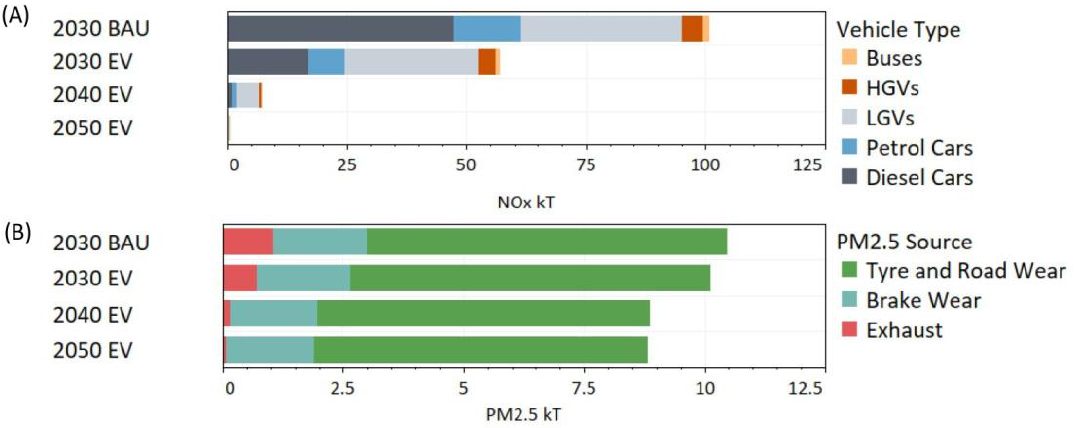
Figure 6. Projected emissions from road transport to 2050 for EV scenario; ( A ) NOx emissions, where colour shows the emissions from each vehicle type; and ( B ) PM 2.5 emissions where colour shows the emission source. Reproduced from